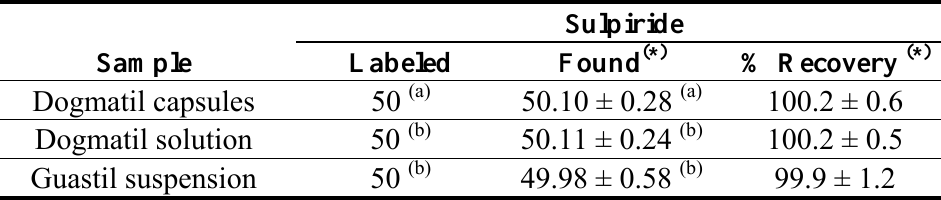
Table 4. Determination of sulpiride in pharmaceuticals.